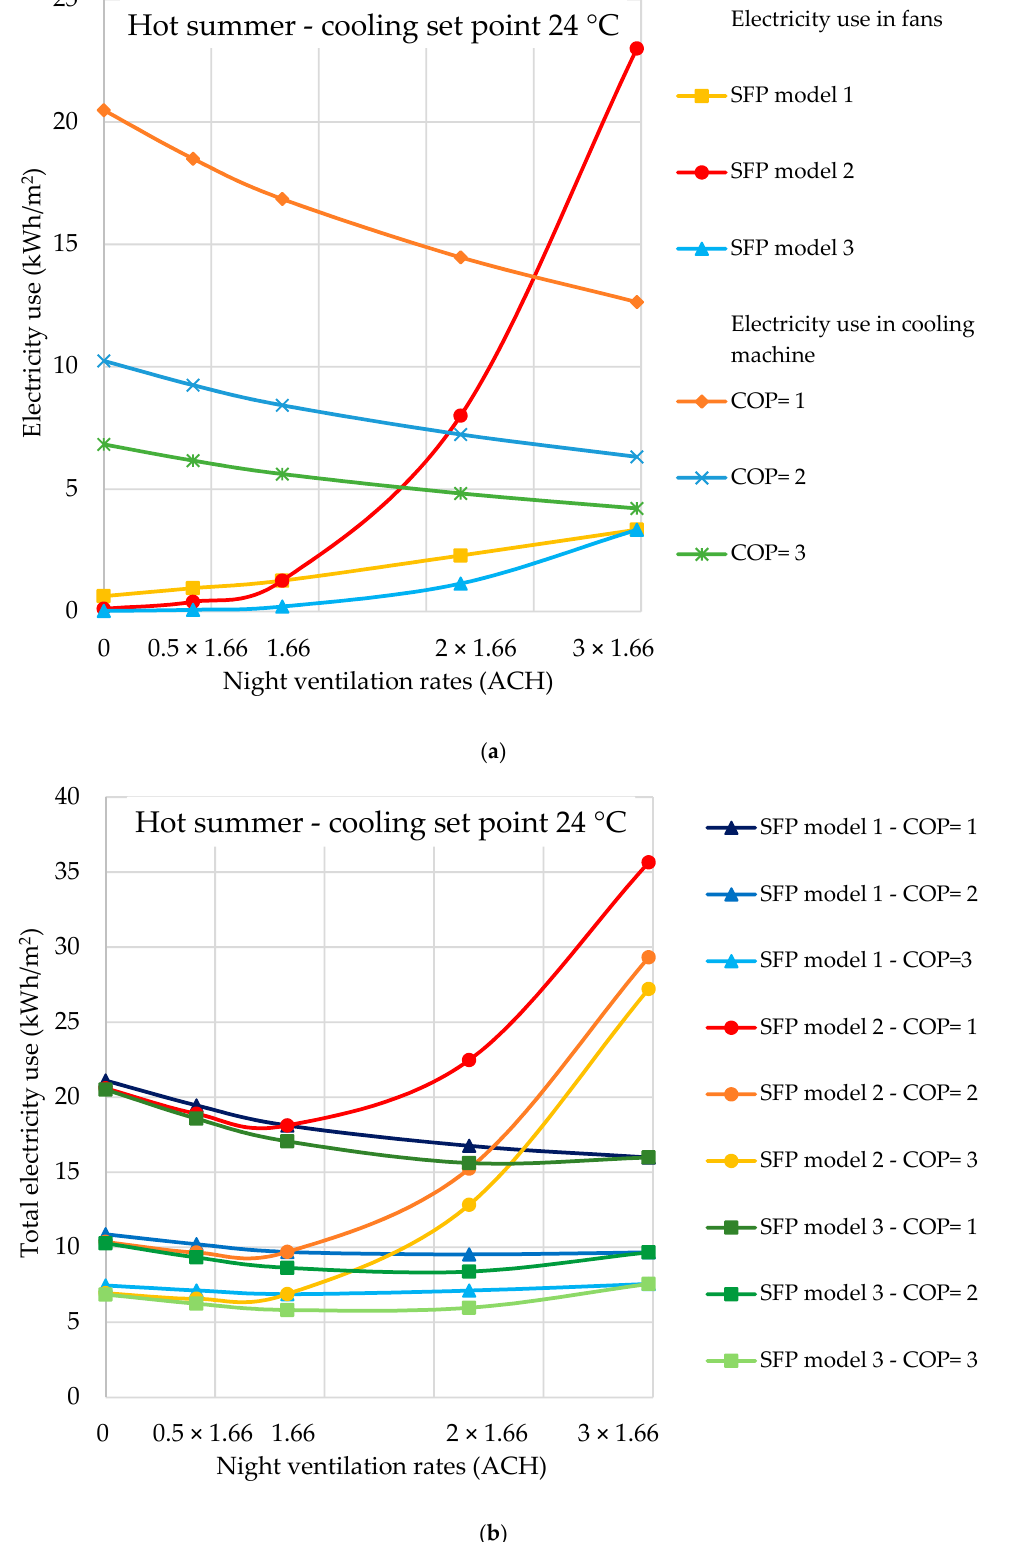
Figure 11. ( a ) individual electricity uses; electricity use in fans and electricity use in cooling machine ( b ) total electricity use for cooling (i.e., electricity use in fans + electricity use in cooling machine); during the hot summer of 2018 for operative temperature cooling set point of 24 °C.